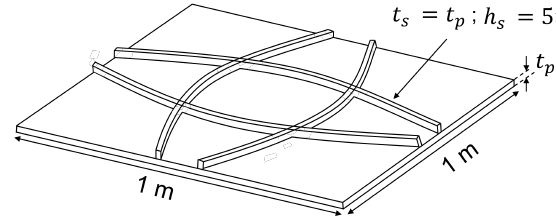
Figure 8. Scheme of the panel to be